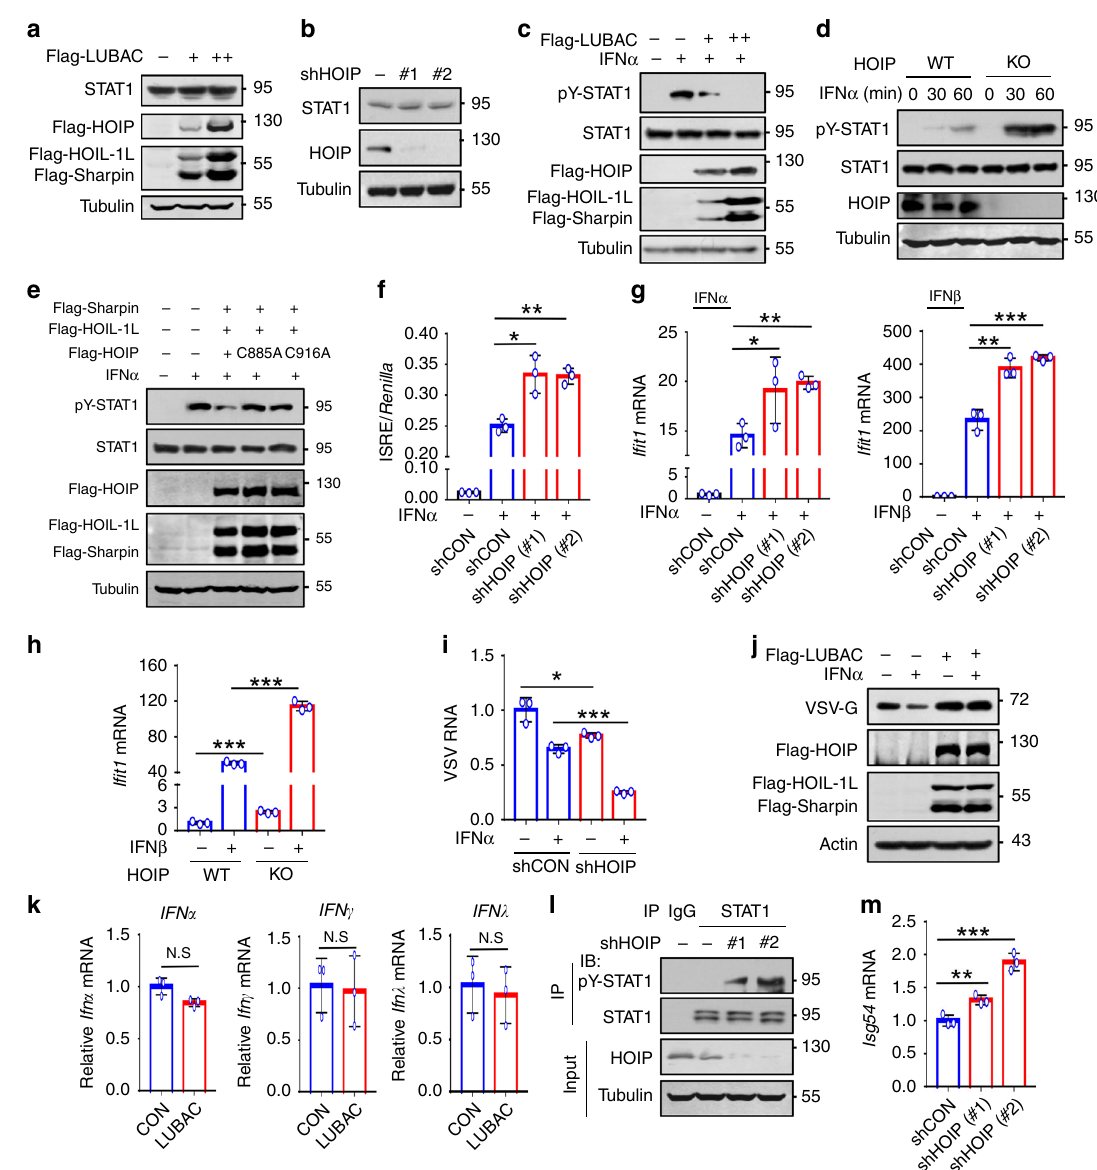
Fig. 2 Linear ubiquitination sustains STAT1 signaling homeostasis. a Western blot analysis of endogenous STAT1 in HEK293T cells transfected with Flag- LUBAC. b Western blot analysis of endogenous STAT1 in HEK293T cells transfected with control shRNAs ( – ) or shHOIP (#1, #2). c Western blot analysis of pY701-STAT1 (pY-STAT1) levels in HEK293T cells transfected with increasing amounts of Flag-LUBAC. d Western blot analysis of pY-STAT1 in HOIP- WT or HOIP-KO HEK293T cells treated with IFN α (1000 IU/ml). e Western blot analysis of pY-STAT1 in HEK293T cells cotransfected with Flag-Sharpin and Flag-HOIL-1L, together with Flag-HOIP wild-type or its catalytically inactivated mutants (C885A and C916A), and then treated with IFN α (1000